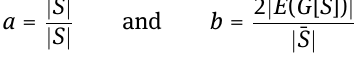
Note that for a κ -regular graph G , q ( G ) = 2 κ and the vertex set V ( G ) is ( κ , 0)-regular. Therefore, κ + τ is a 1 trivial lower bound on the index of the signless Laplacian matrix of a regular